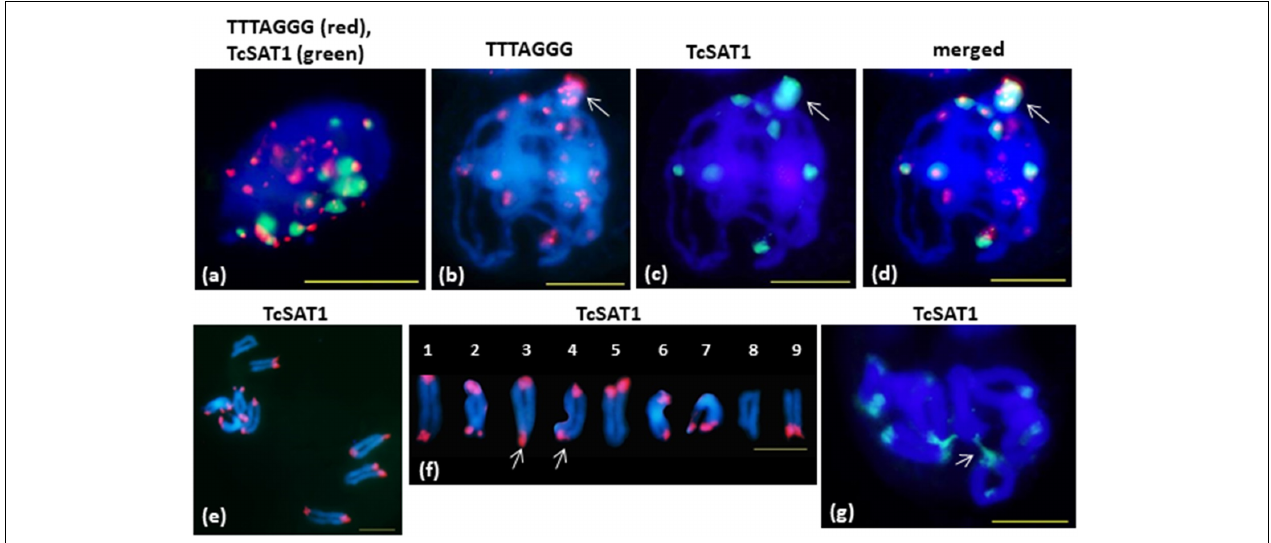
FIGURE 5 | FISH mapping of TcSAT1 and TcSAT2 satellite DNA repeats and Arabidopsis -type (TTTAGGG) n telomeric repeats on meiotic pachytene (a–d) and diakinesis (e–g) chromosomes of T. cinerariifolium (2 n = 18). (a) Rabl formation showed with telomeric sequence TTTAGGG (red) and TcSAT1 (green) as probes. (b–g) TcSAT1 (green) and/or TcSAT2 (red). (a,g) accession Africa-7, (c,d) accession 32-2, (e,f) accession 53-3. Arrow in ( b–d) mark association of TcSAT1 and TcSAT2 sites. Bivalents in (f) are arranged according to metaphase chromosomes shown on the Figure 2p . Arrow in (f) points to a bivalents that show heterozygosity of subtelomeric heterochromatin. Arrow in (g) indicates connection between non-homologous chromosomes. Scale bar, 10 µ m.